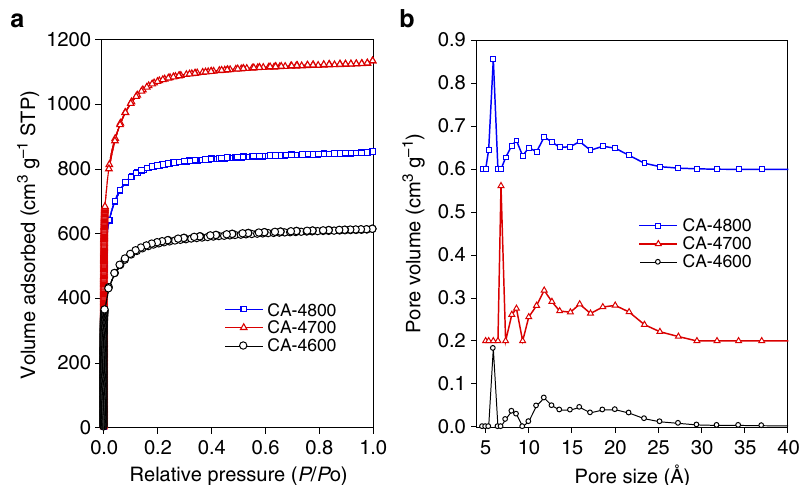
Fig. 2 Porosity of activated carbons prepared from cellulose acetate. The activated carbons are labelled as CA-4T, where 4 is the activation KOH/carbon ratio and T is the activation temperature. The nitrogen sorption isotherms ( a ) and corresponding pore size distribution curves ( b ) are